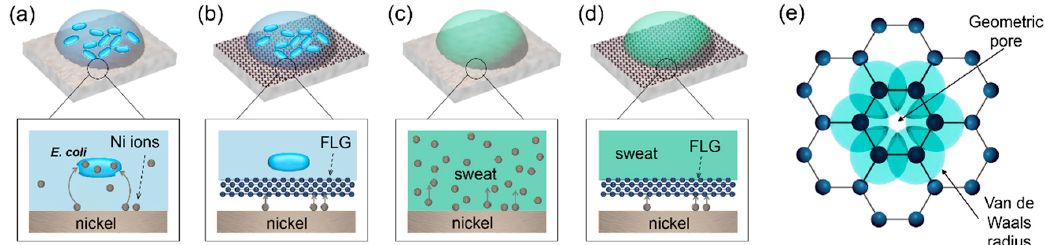
Figure 6. Diagram of FLG-coated Ni performance under biocorrosion and Ni hypersensitivity conditions inferred from our study. ( a ) Uncoated Ni samples (NiT or NiF) interacts with bacteria, releasing metal ions which lead to cell death; ( b ) For graphene-coated Ni, there is no interaction between bacteria and underlying substrate, leading to reduction of biocorrosion and, in consequence decrease of Ni bactericide activity; ( c ) Sweat, in contact with Ni (fresh or treated), boosts release of a high amount of Ni ions; ( d ) Graphene coating prevent Ni ions release in sweat which is related to Ni hypersensitivy in humans; ( e ) Geometric pore size of graphene determines a high impermeability to Ni ions.